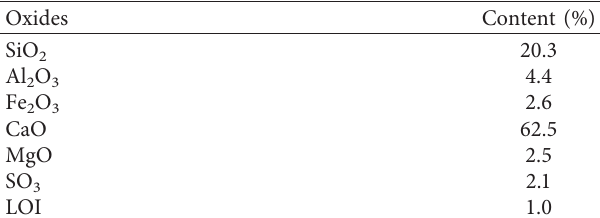
Table 1: Chemical composition of